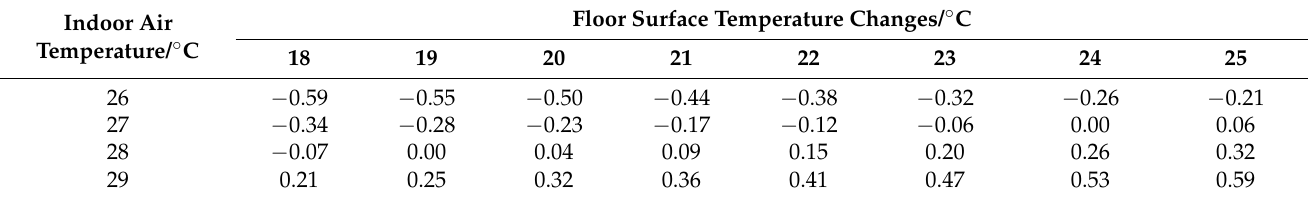
Table 4. PMV values for different indoor air temperatures and floor surface